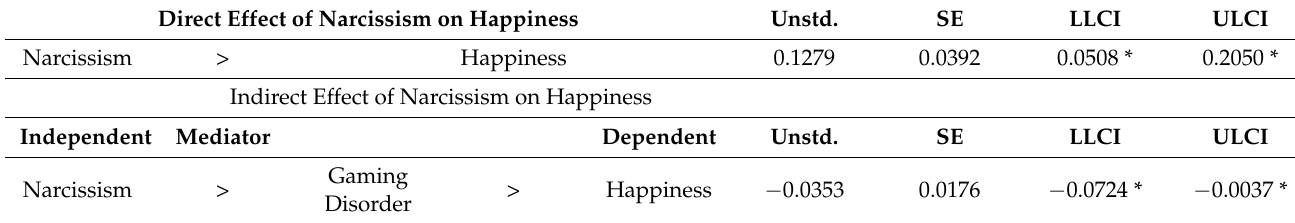
Table 5. Direct and indirect effects.